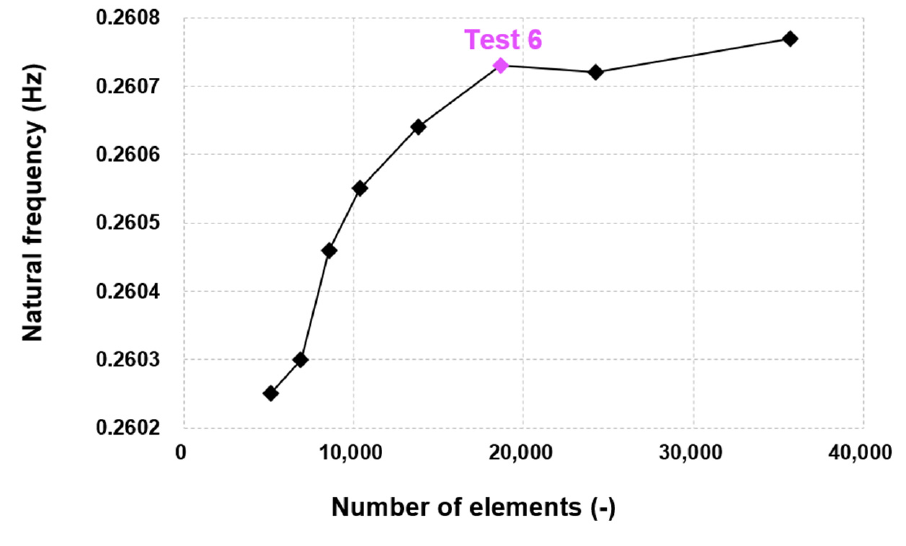
Figure 4. Mesh convergence graph.